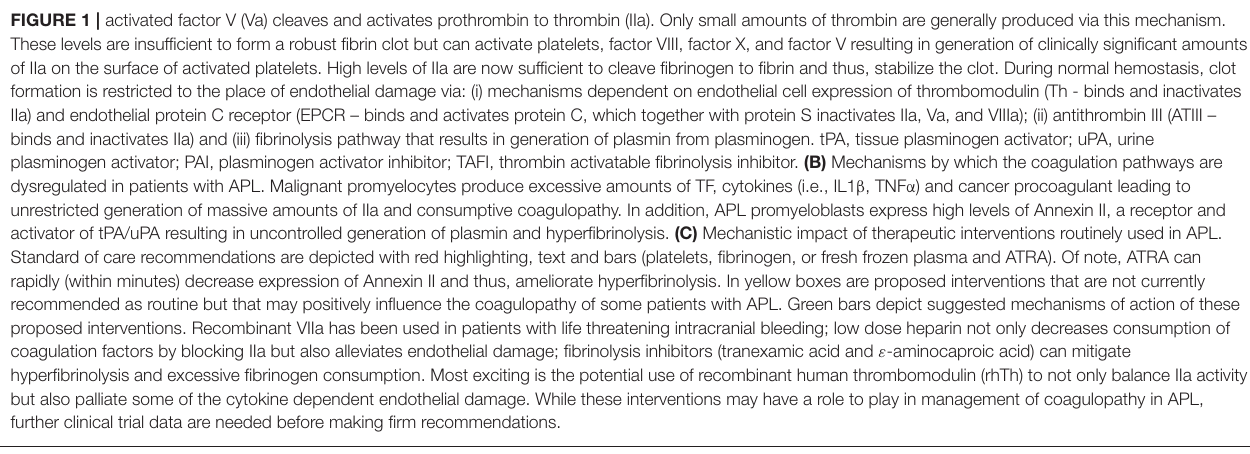
FIGURE 1 | activated factor V (Va) cleaves and activates prothrombin to thrombin (IIa). Only small amounts of thrombin are generally produced via this mechanism. These levels are insufficient to form a robust fibrin clot but can activate platelets, factor VIII, factor X, and factor V resulting in generation of clinically significant amounts of IIa on the surface of activated platelets. High levels of IIa are now sufficient to cleave fibrinogen to fibrin and thus, stabilize the clot. During normal hemostasis, clot formation is restricted to the place of endothelial damage via: (i) mechanisms dependent on endothelial cell expression of thrombomodulin (Th - binds and inactivates IIa) and endothelial protein C receptor (EPCR – binds and activates protein C, which together with protein S inactivates IIa, Va, and VIIIa); (ii) antithrombin III (ATIII – binds and inactivates IIa) and (iii) fibrinolysis pathway that results in generation of plasmin from plasminogen. tPA, tissue plasminogen activator; uPA, urine plasminogen activator; PAI, plasminogen activator inhibitor; TAFI, thrombin activatable fibrinolysis inhibitor. (B) Mechanisms by which the coagulation pathways are dysregulated in patients with APL. Malignant promyelocytes produce excessive amounts of TF, cytokines (i.e., IL1 β , TNF α ) and cancer procoagulant leading to unrestricted generation of massive amounts of IIa and consumptive coagulopathy. In addition, APL promyeloblasts express high levels of Annexin II, a receptor and activator of tPA/uPA resulting in uncontrolled generation of plasmin and hyperfibrinolysis. (C) Mechanistic impact of therapeutic interventions routinely used in APL. Standard of care recommendations are depicted with red highlighting, text and bars (platelets, fibrinogen, or fresh frozen plasma and ATRA). Of note, ATRA can rapidly (within minutes) decrease expression of Annexin II and thus, ameliorate hyperfibrinolysis. In yellow boxes are proposed interventions that are not currently recommended as routine but that may positively influence the coagulopathy of some patients with APL. Green bars depict suggested mechanisms of action of these proposed interventions. Recombinant VIIa has been used in patients with life threatening intracranial bleeding; low dose heparin not only decreases consumption of coagulation factors by blocking IIa but also alleviates endothelial damage; fibrinolysis inhibitors (tranexamic acid and ε -aminocaproic acid) can mitigate hyperfibrinolysis and excessive fibrinogen consumption. Most exciting is the potential use of recombinant human thrombomodulin (rhTh) to not only balance IIa activity but also palliate some of the cytokine dependent endothelial damage. While these interventions may have a role to play in management of coagulopathy in APL, further clinical trial data are needed before making firm